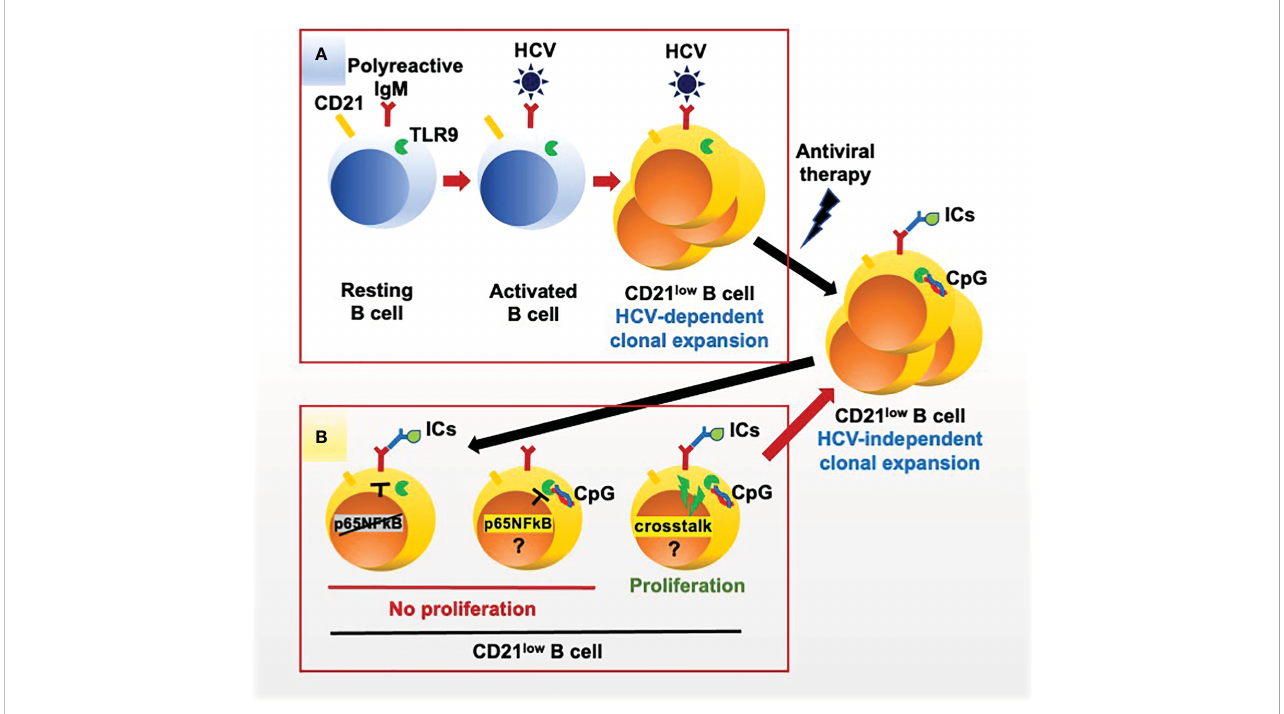
FIGURE 5 HCV-dependent and autoantigen-dependent expansion of rheumatoid factor B cell clones in mixed cryoglobulinemia. (A) HCV drives the proliferation of clones of B cells expressing a polyreactive BCR endowed with anti-HCV and rheumatoid factor speci fi cities; the expanded B cell clones acquire a peculiar CD21 low phenotype and functional exhaustion. (B) Once HCV is cleared by antiviral therapy CD21 low B cell clones survive for a long time; these exhausted cells fail to proliferate in response to the engagement of the BCR by autoantigen (immune complexes, ICs) and of TLR9 by CpG but proliferate in response to the simultaneous engagement of both receptors, possibly supporting the virus-independent survival of pathogenic CD21 low B cell clones in vivo . Phosphorylation of the NF-kB p655 subunit is de fi cient after BCR stimulation and pro fi cient after TLR9 stimulation; thus, the mechanisms for reduced proliferation of CD21 low B cell clones after TLR9 stimulation and for the BCR/TLR9 positive crosstalk remain unde fi